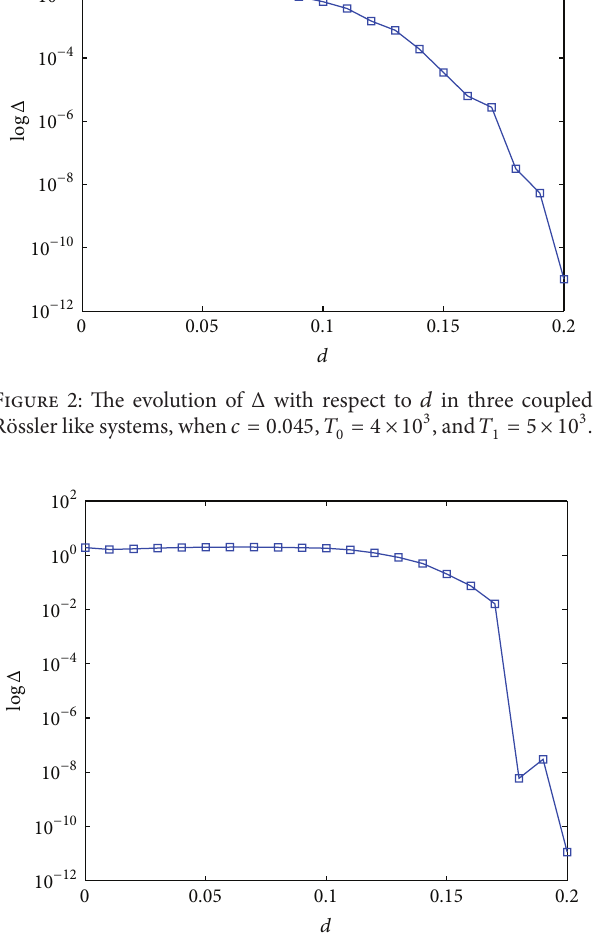
Figure 3: The evolution of Δ with respect to 𝑑 in three coupled Lorenz systems, when 𝑐 = 0.002 , 𝑇 0 = 4 × 10 3 , and 𝑇 1 = 5 × 10 3